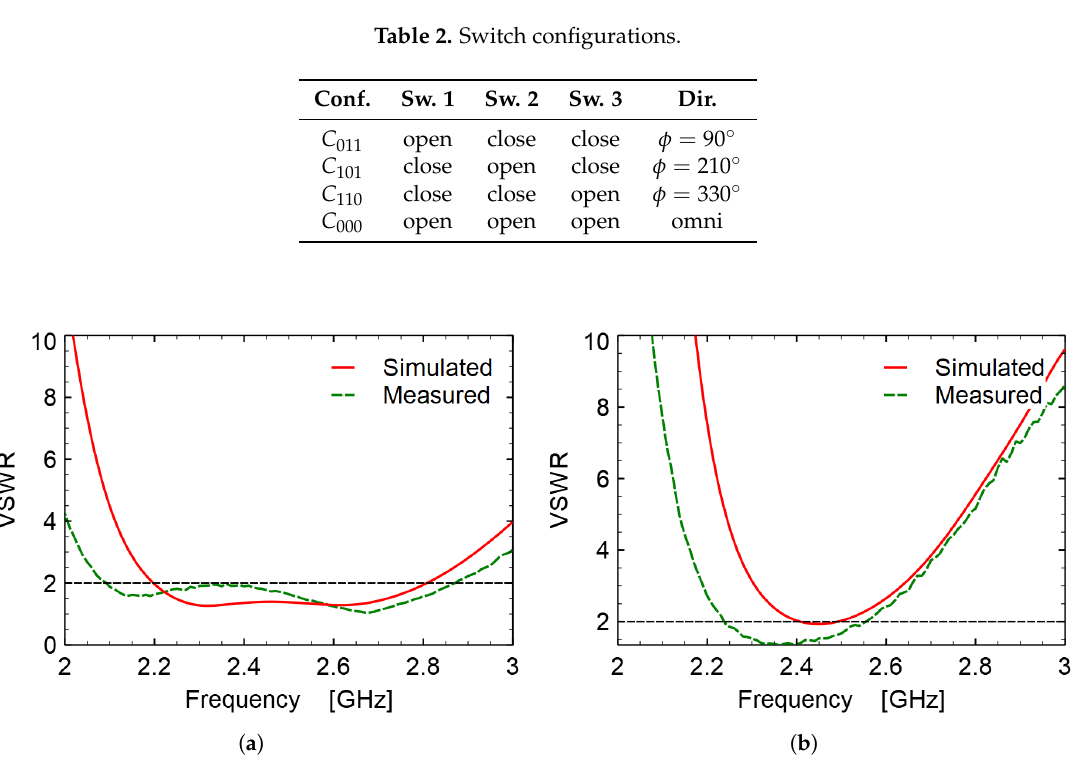
Figure 2. Simulated and measured impedance matching (VSWR values) of the proposed antenna in the ( a ) C 000 and ( b ) C 011